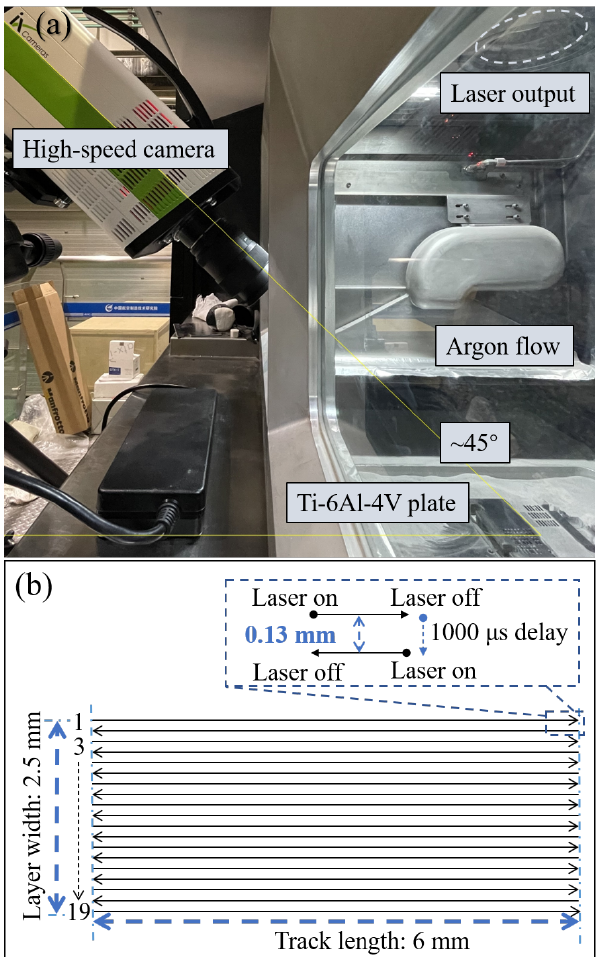
Figure 1. Experimental design and scanning strategy. ( a ) Experimental setup and off-axis high speed observation solution and ( b ) scan pattern used in multi-track laser scan